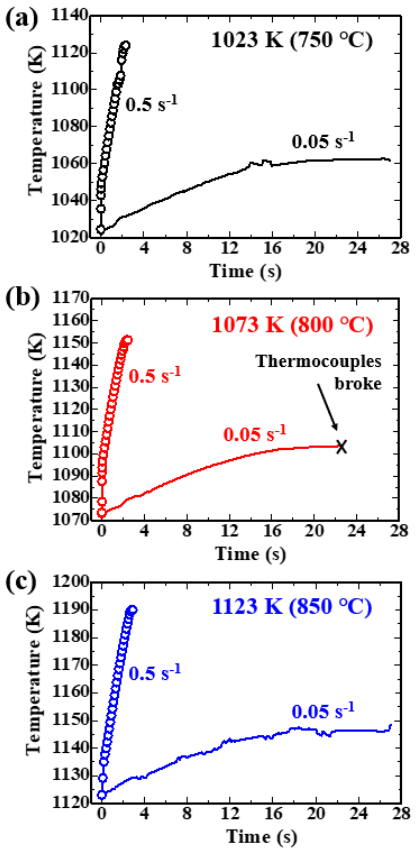
Figure 7. Temperature increases at the center of the workpiece during forging with 0.5 and 0.05 s −1 at ( a ) 1023, ( b ) 1073, and ( c ) 1123 K (750 °C, 800 °C, and 850 °C, respectively).